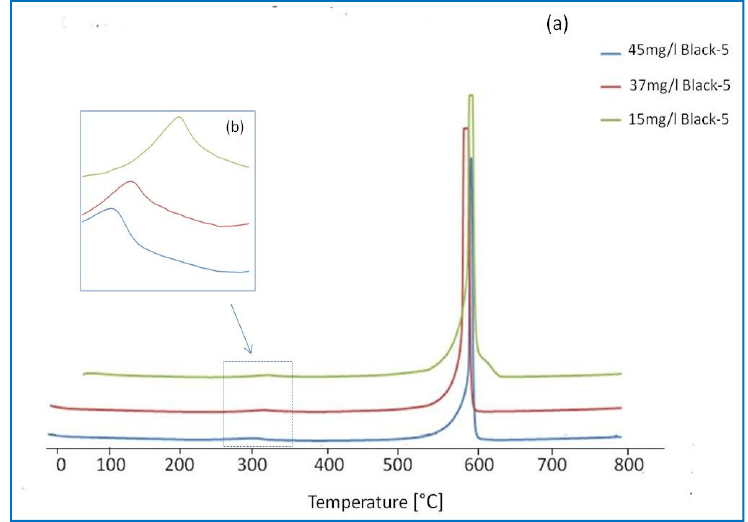
Table 2. Partial and total post-treatment weight losses of purified MWCNTs for di ff erent concentrations.